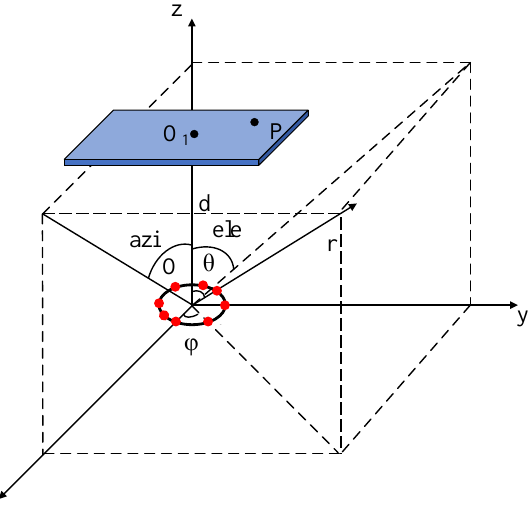
Figure 1. The coordinate system of the antenna array and